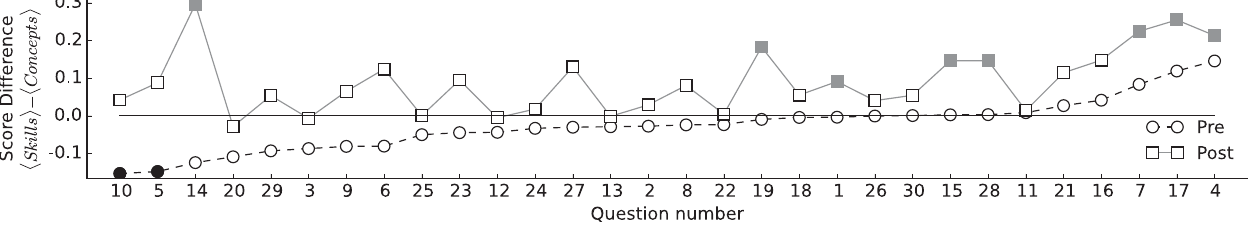
FIG. 2. Sorted plot of the difference between the average scores (points) of FY students in skills-focused and concepts-focused courses for each item of the E-CLASS. Zero difference is marked by the solid horizontal line. Filled markers indicate points for which the difference between the distributions was statistically significant (Mann-Whitney U [24] and Holm-Bonferroni [32] corrected p < 0 . 05 ). See Ref. [33] for full list of item